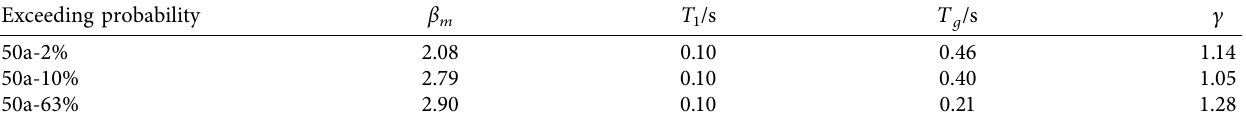
Table 8: Calibration of design spectral characteristic parameters by the least-squares piecewise fitting method.